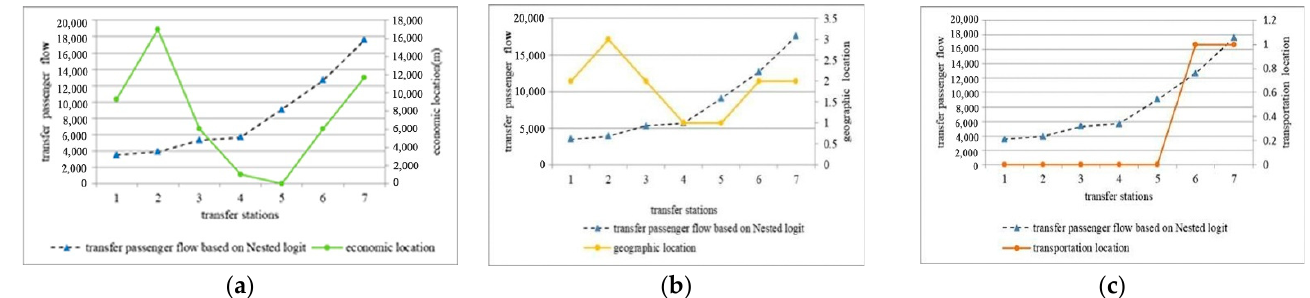
Figure 7. ( a ) The relationship between transfer passenger flow and economic location; ( b ) the relationship between transfer passenger flow and geographic location; ( c ) the relationship between transfer passenger flow and transportation location. In the figure, 1–7 refer to Yuantong, Taifeng Road, Andemen, Daxinggong, Xinjiekou, Nanjing Railway Station, and Nanjing South Railway Station, respectively.